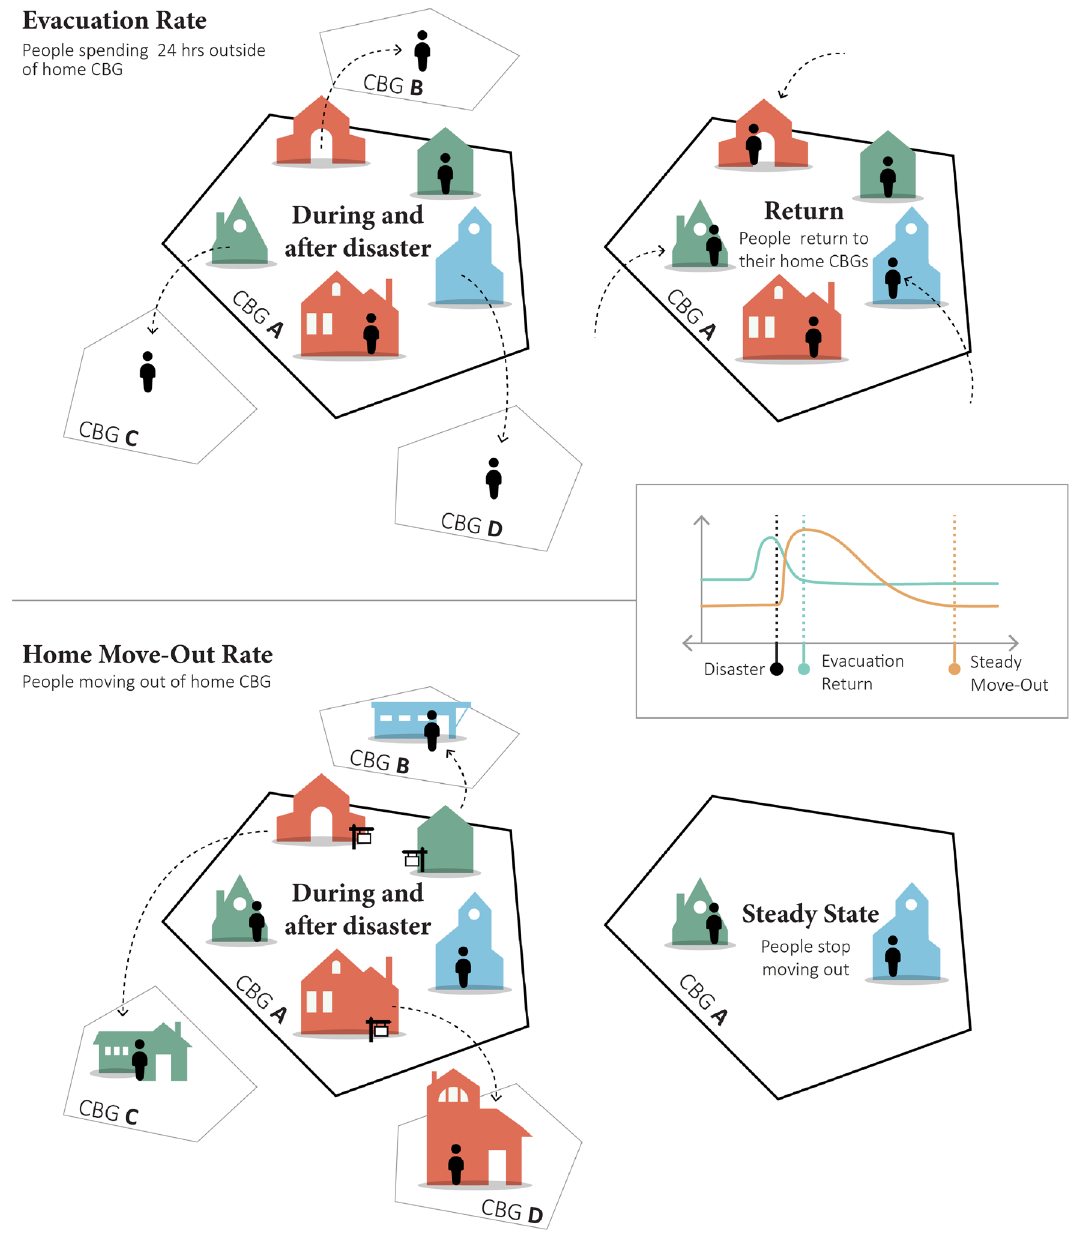
Figure 1. Schematic illustration of two critical community recovery milestones, evacuation return and home- switch stability assessing by evacuation and home move-out rates (The figure is for illustration purposes and not drawn to